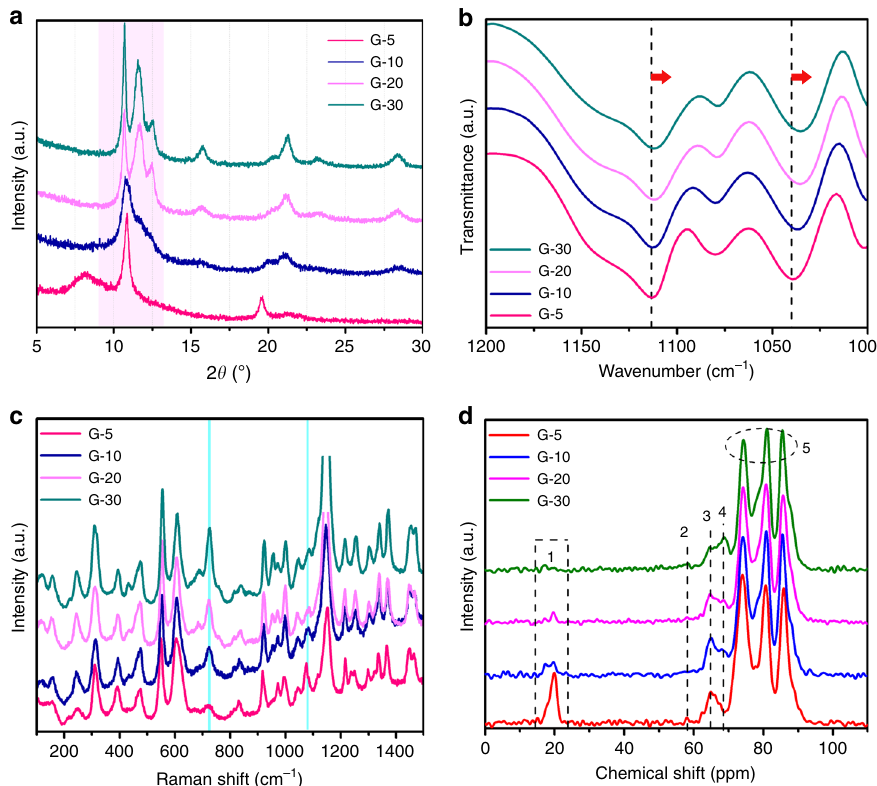
Fig. 1 Crystal structures of as-synthesized titanium glycerolates (G-5, G-10, G-20, and G-30). a Enlarged XRD patterns (with 2 θ in the range of 5° – 30°), b Fourier-transform infrared spectroscopy (FT-IR), c Raman spectra, and d solid-state CP/MAS 13 C-NMR spectra.